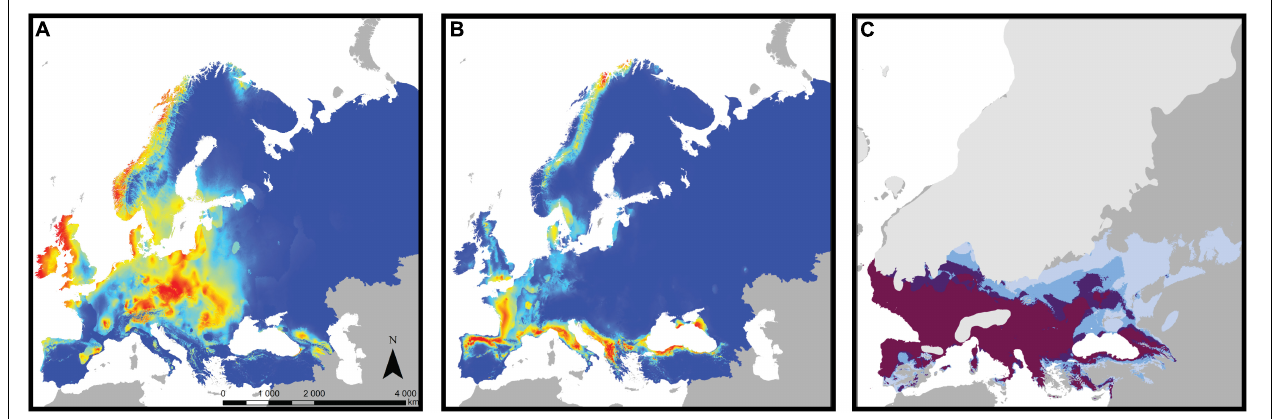
FIGURE 6 | Climate suitability estimated by ecological niche modeling for the bank vole and its lineages. Heat maps of current climate suitability for (A) the Carpathian clade and (B) the southern clade (combining the three Mediterranean clades; see text for details), with warmer colors indicating higher suitability. (C) Areas where the climate of the Last Glacial Maximum is suitable for bank vole, with darker colors indicating support from an increasing number of models from a total of four models, each of which considered a different climate data set (adapted from Escalante et al.,